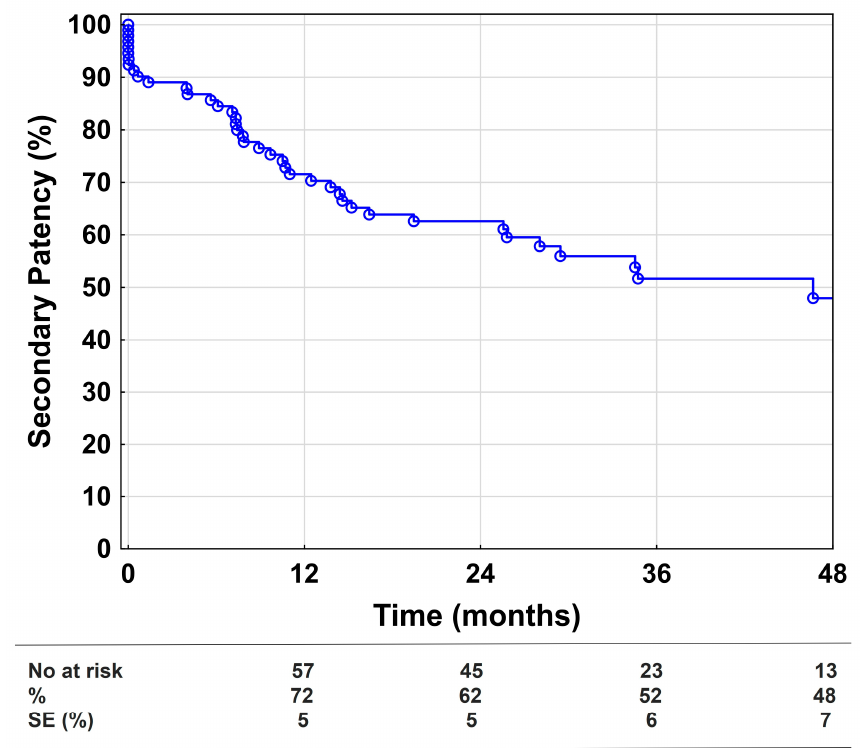
Figure 2. Secondary patency. Kaplan–Meier estimates presenting secondary patency during the 48-month follow-up, including all technically successful cases ( n = 96). SE = standard error. Freedom from TLR was 75%, 73%, and 58% at 1, 2, and 4 years, respectively (Figure 3). Distal embolization was the biggest risk factor for TLR in the univariate and multivariable Cox regression models, while popliteal stenting was only significant in the univariate analysis, see Table 4. A total of 86 revascularizations were performed after the index- interventions (53 redo-angioplasties, 20 bypass procedures, nine surgical thrombectomies, and four catheter-directed thrombolyses). Due to clinical improvement despite restenosis ( n = 4) or reocclusion ( n = 15) of the treated lesions, patients did not receive further interventions during